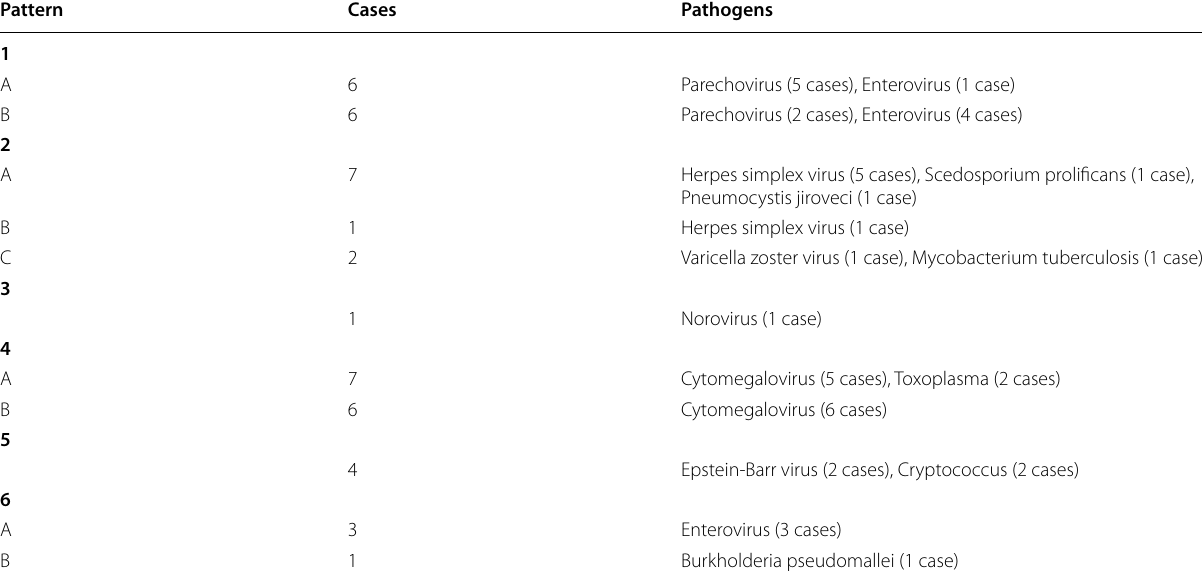
Table 1 Summary of pathogens encountered in Western Australia, pertaining to each pattern Pattern Cases